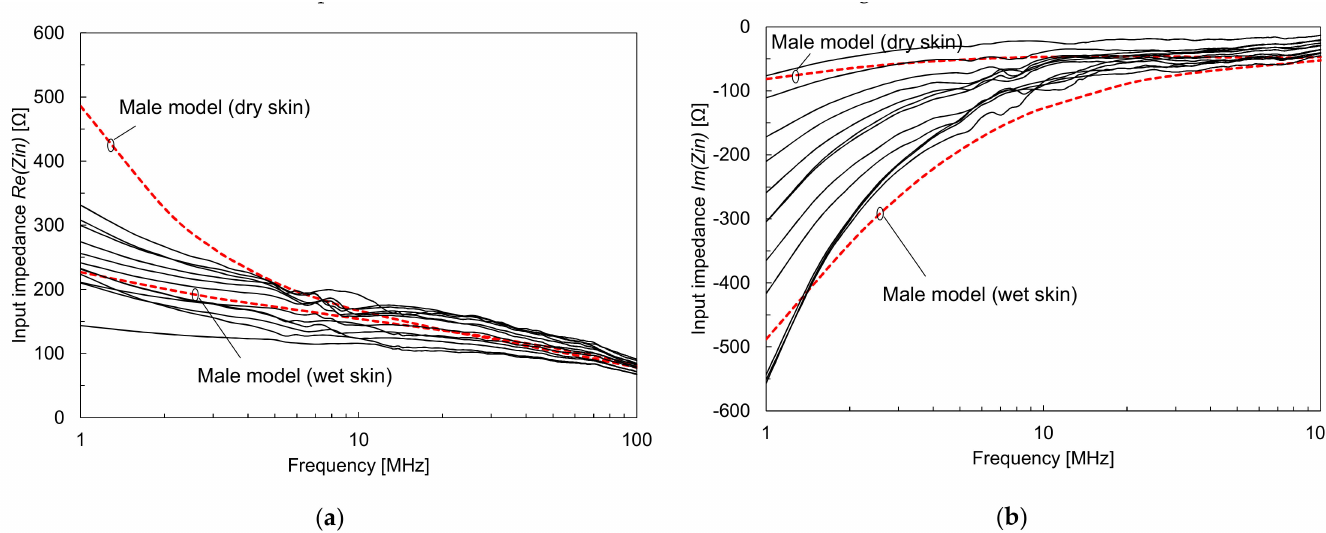
Figure 7. Input impedance characteristics of the wearable antenna measured by using male subjects: ( a ) Real component of input impedance characteristics; ( b ) imaginary component of input impedance